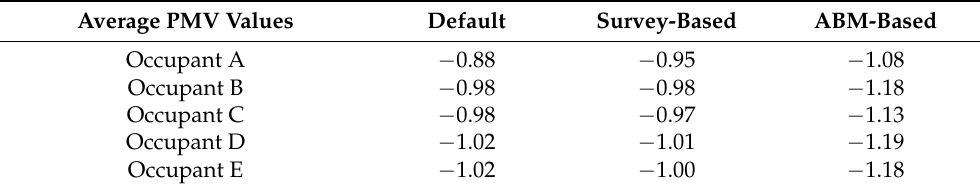
Table 5. Predicted Mean Vote Index (PMV) statistics for experiment occupants. Average PMV Values Default